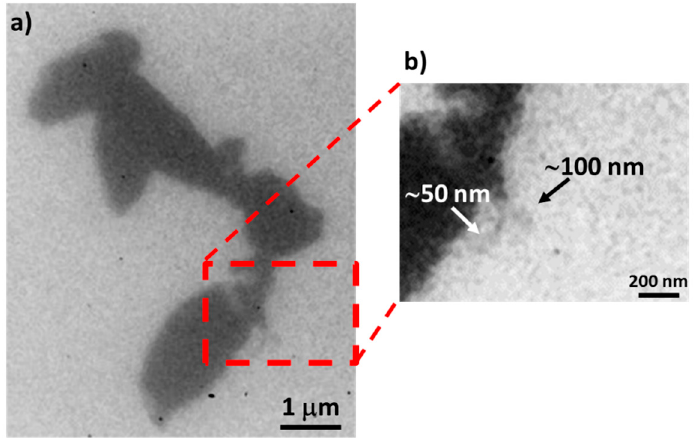
Figure 15. ( a ) Chrysodidymus synuroideus algae imaged with the EUV microscope. In ( b ) small features ( ∼ 50–100 nm) are resolved. Figure modified, based on [76].